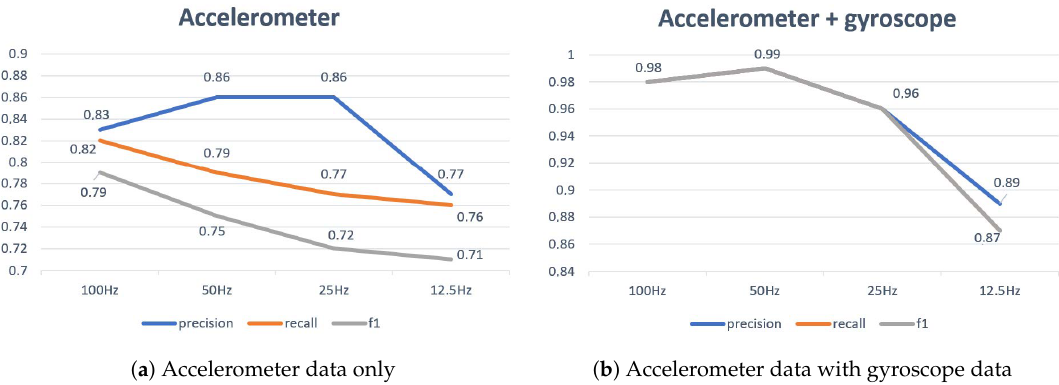
Figure 5. Precision, recall and f1 score measured with ( a ) accelerometer data only or in ( b ) combination with gyroscope data at sample frequencies of 100, 50, 25, and 12.5 Hz.